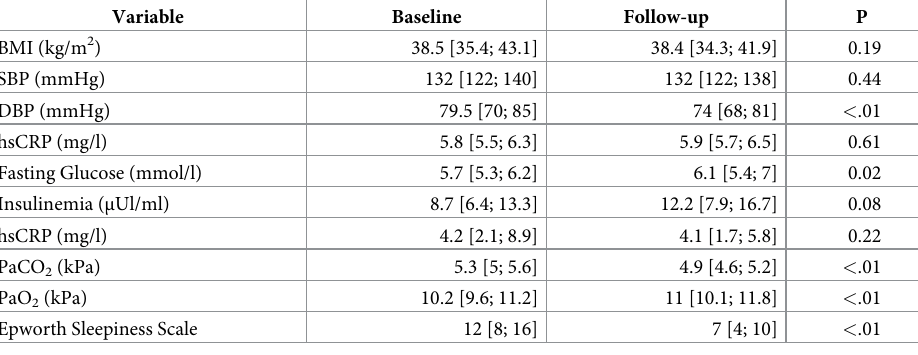
Table 3. Comparison between baseline and follow-up values.